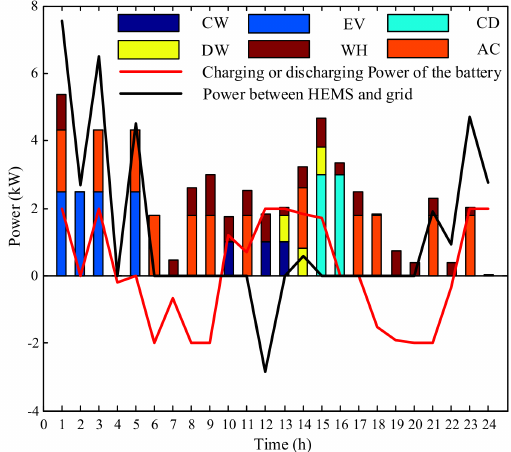
Figure 3. The schedules of household appliances (without considering the uncertainties). CW: clothes washers; EV: electric vehicles; CD: clothes dryer; DW: dishwasher; WH: water heater; AC: air